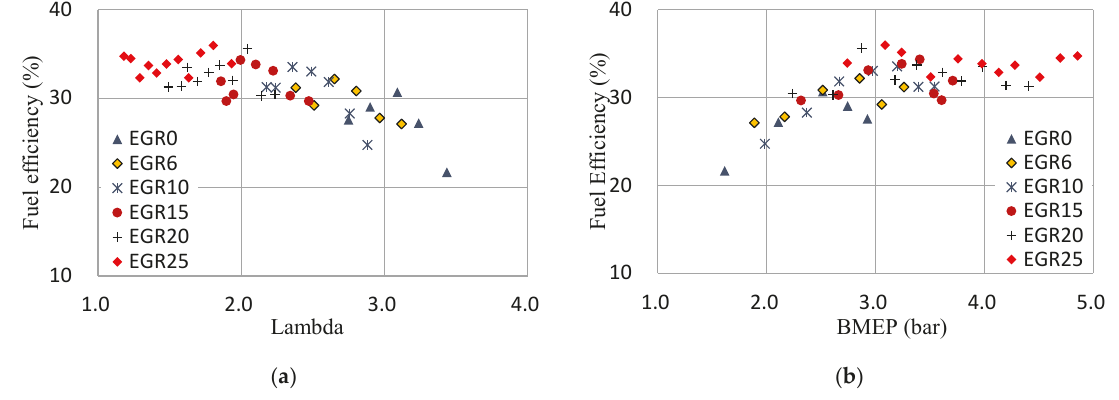
Figure 8. Fuel efficiency with respect to: ( a ) Lambda; ( b ) BMEP.